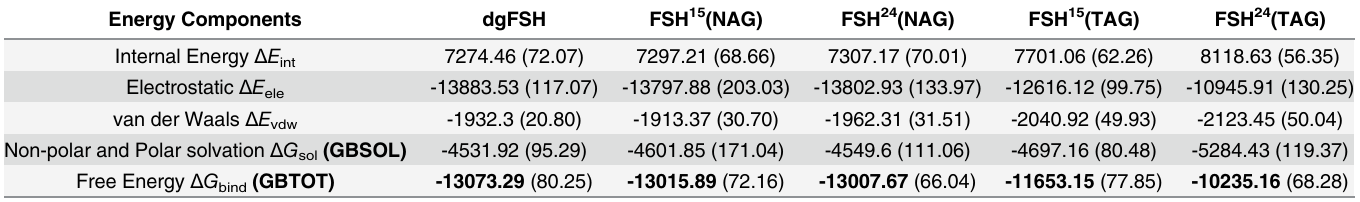
Table 1. FSH/FSHR binding free energies as computed from GBSA molecular dynamics studies. Values are in kcal/mol. Parenthetical values repre- sent standard deviations in the free energies. Energy